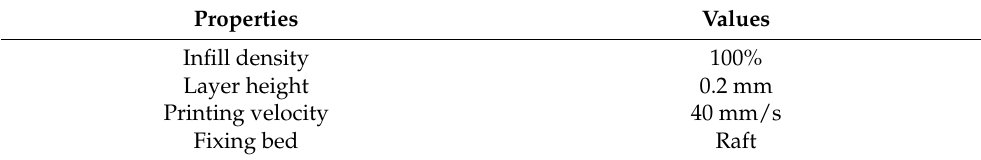
Table 3. Settings of 3D printer used to fabricate multi-celled interconnected metamaterials.